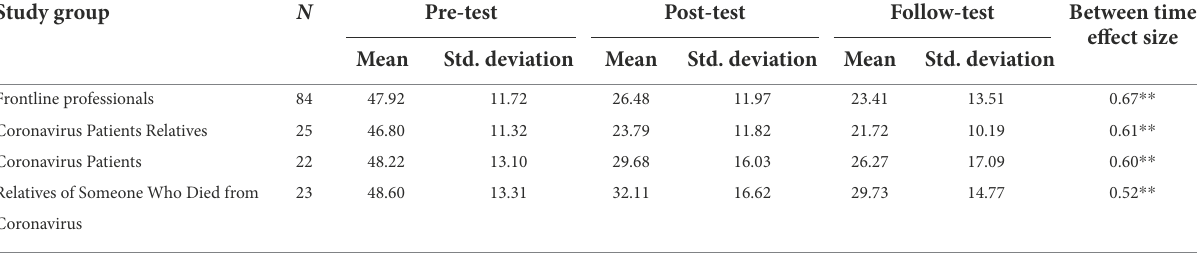
TABLE 3 Descriptive statistics of the study